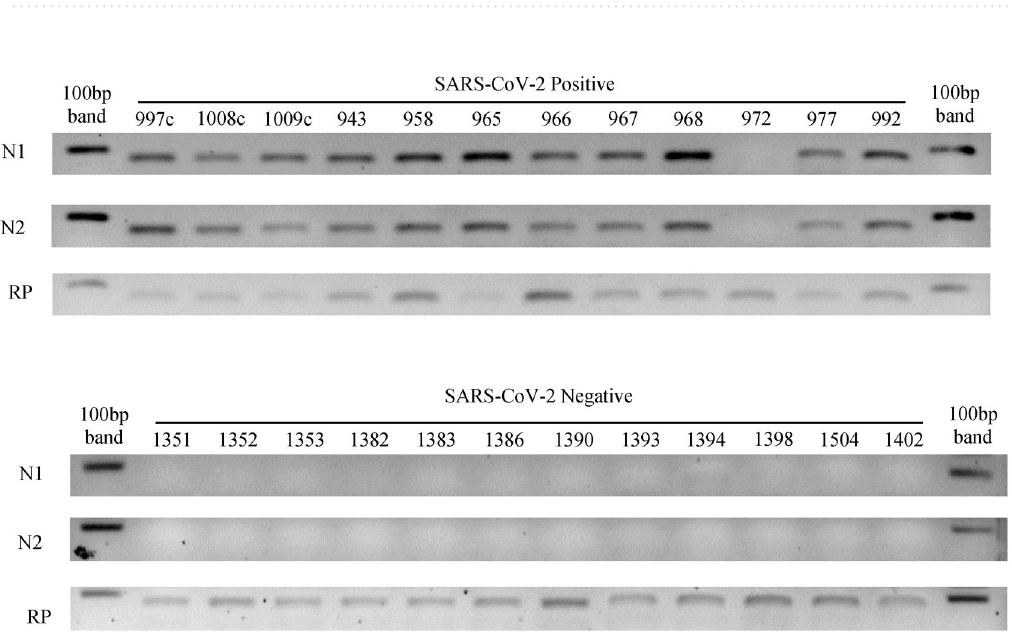
Table 1. Clinical performance of two step end point RT-PCR compared to the CDC RT-qPCR protocol for SARS-CoV-2 detection.